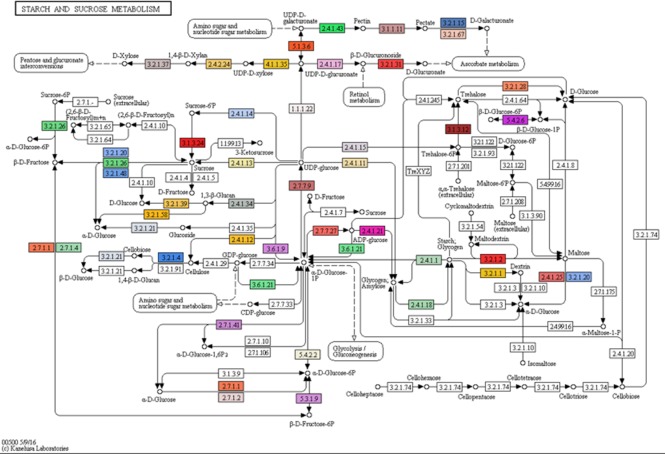
Mapping of assembled transcripts onto the starch and sucrose metabolism (map00500) taken from KEGG.Mapped enzymes are indicated by colors (see Table S10 for details). Kanehisa Laboratories 00500 5/9/16.